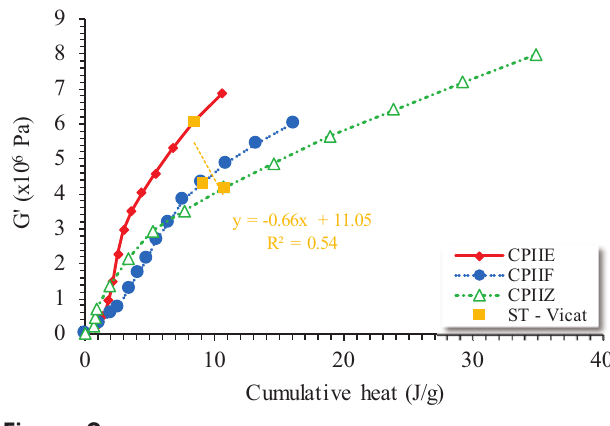
Figure 9 Relationship between the rate of chemical reaction and the consolidation rate